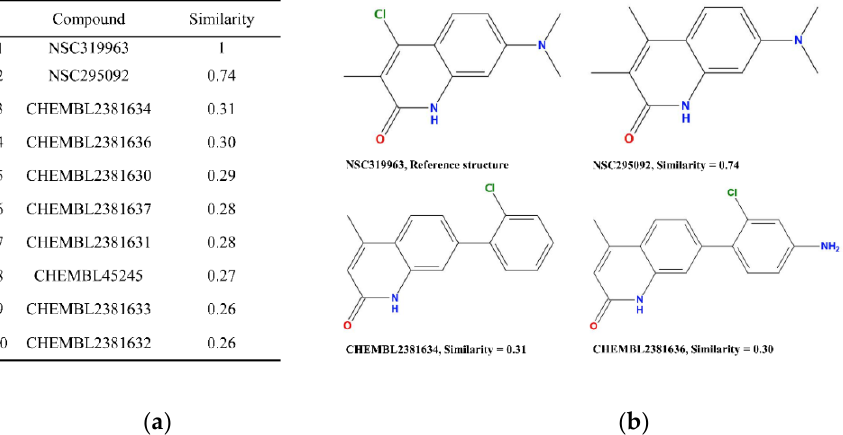
Figure 6. The similarity of screened compounds NSC319963 and NSC295092. ( a ) The structure similarity of NSC319963, NSC295092 and know TNKSs inhibitors. ( b ) The most similar compounds and their structures.